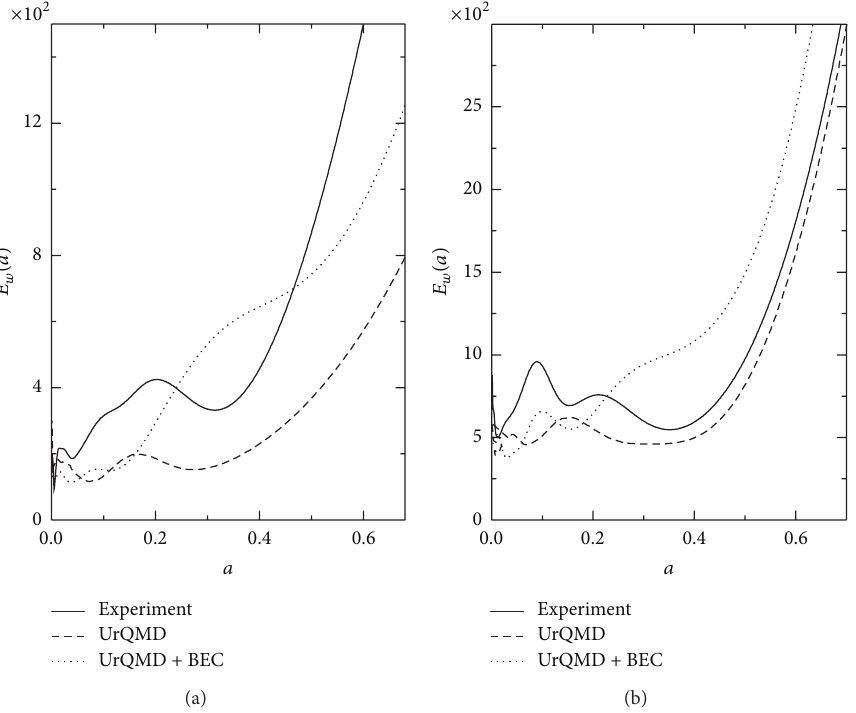
Figure 5: Scalogram for a single event: (a) 28 Si-Ag/Br interaction at 14.5AGeV: event multiplicity 146, and (b) 32 S-Ag/Br interaction at 200AGeV: event multiplicity 379. The same events for which the wavelet pseudorapidity spectra are shown in Figure 4 are used for drawing the